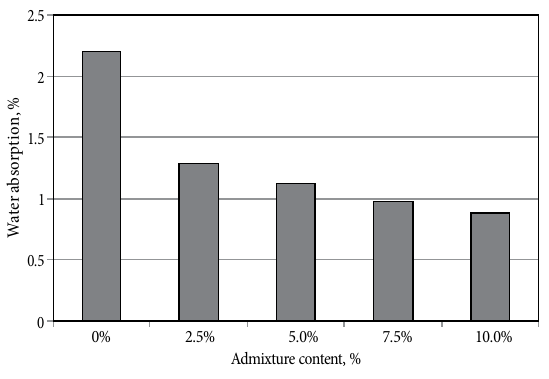
Fig. 4. Function of water absorption and amorphous alumina silicate admixture